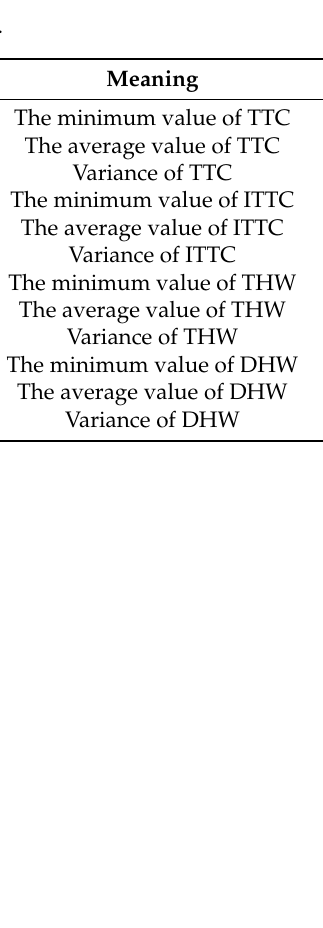
Table 3. List of driving style clustering characteristics.